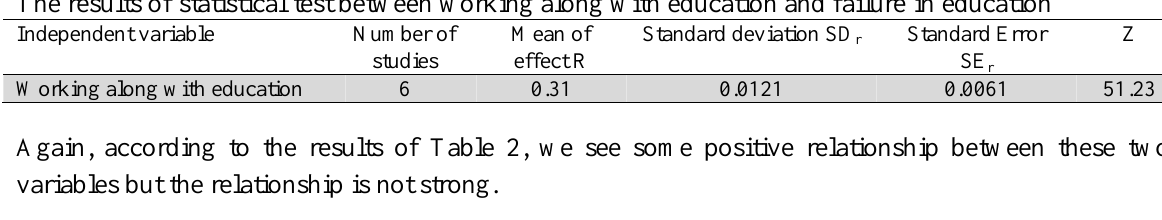
The results of statistical test between working along with education and failure in education Independent variable Number of Working along with education